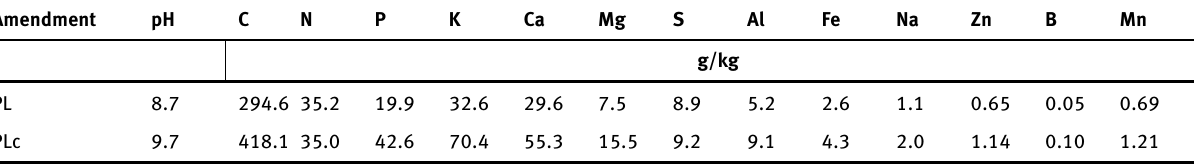
Table 2: Total carbon and nutrient content of the organic amendments (means, n=3) Amendment